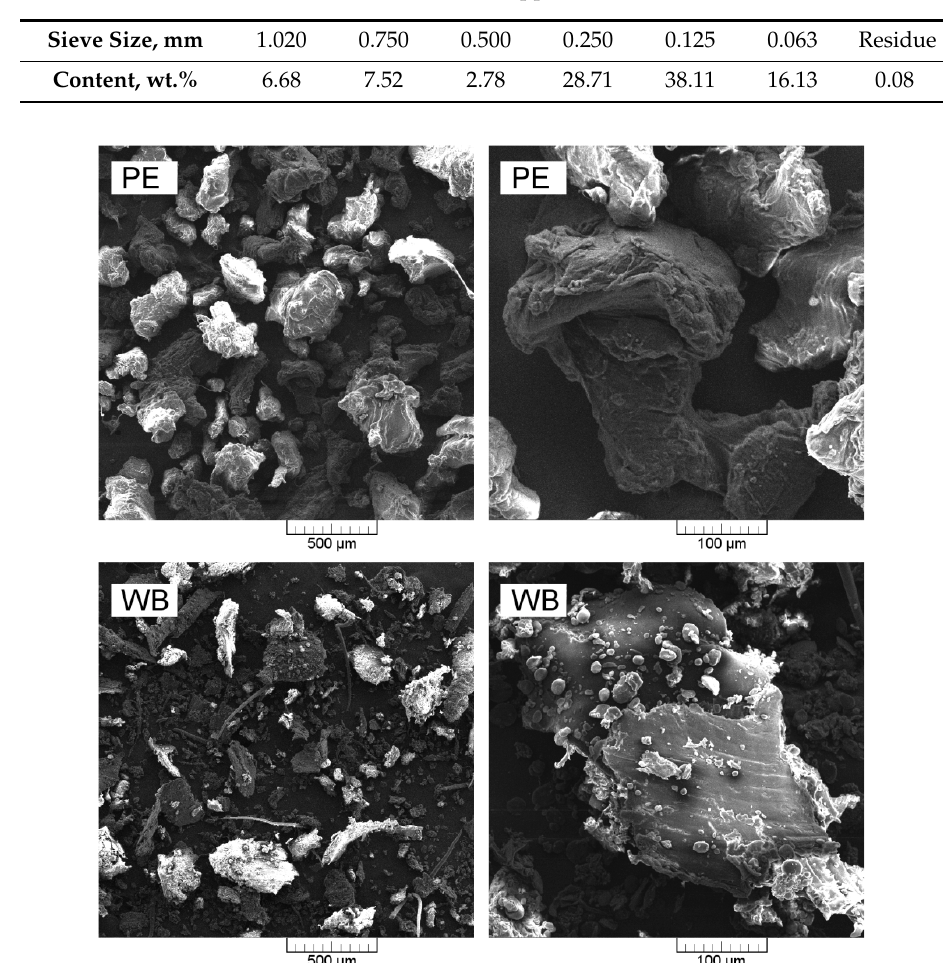
Table 1 . Particle size distribution of applied wheat bran (WB) filler. Table 1. Particle size distribution of applied wheat bran (WB) filler.